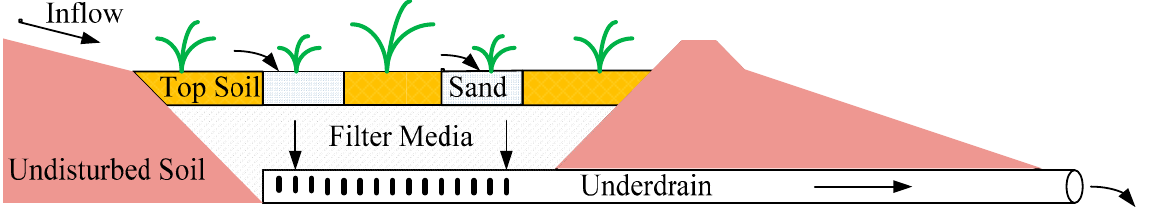
Figure 2. Typical BRC cross section (not to scale).